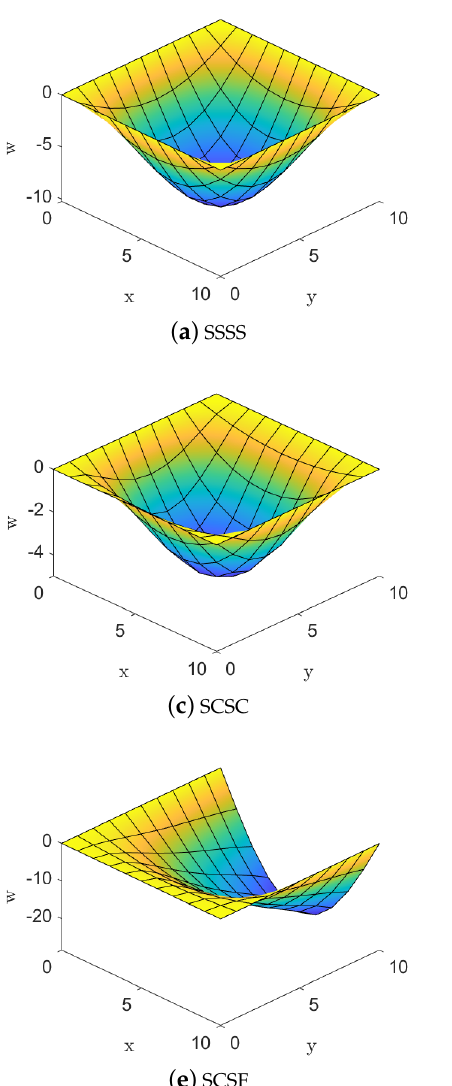
Figure 6. Deformed shapes of square isotropic nanoplates with different boundary